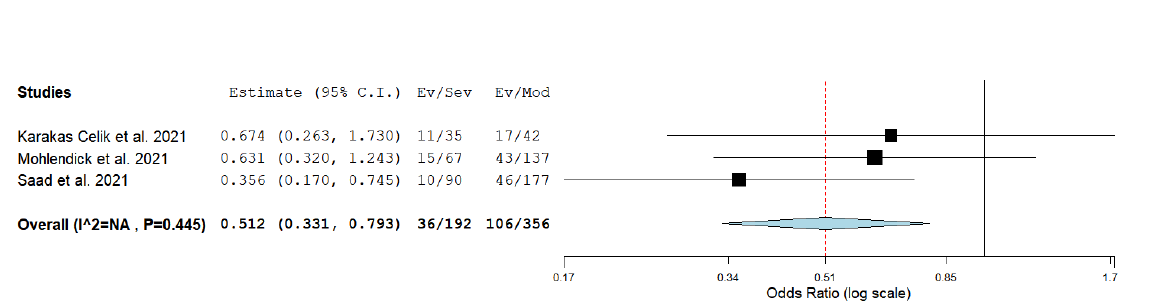
Figure 6: Meta-analysis of the association between rs2285666 in ACE2 and COVID-19 severity under the dominant genetic model (carriers vs. non-carriers): comparison severe vs. moderate. The results of the included studies presented as ORs, with 95 % CI, and the overall effect with 95 % CI are shown in the forest plot. P values given are derived from heterogeneity